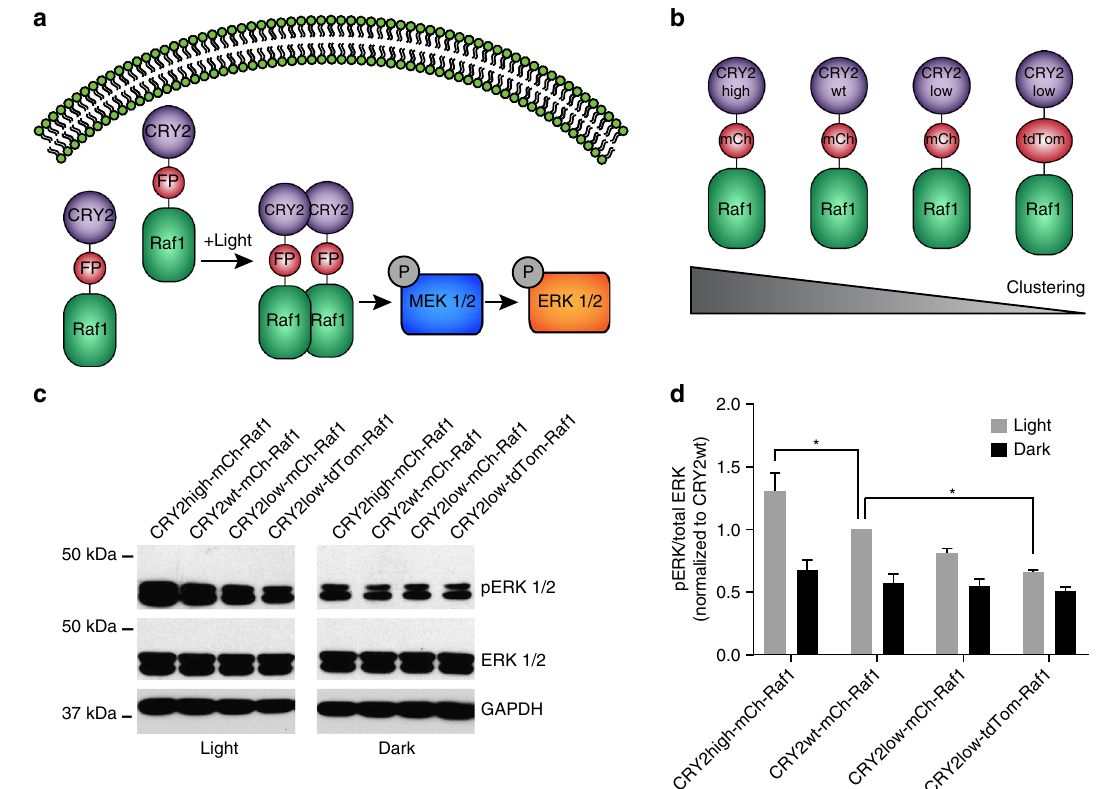
Fig. 5 Optical control of Raf activation using CRY2 constructs with differential clustering capacities. a Illustrative scheme for light-induced activation of MAPK signaling pathway. b Light-activatable Raf1 with different CRY2 oligomerization propensities. c Cells expressing CRY2high-mCh-Raf1 yielded the highest level of pERK after light stimulation, while cells expression CRY2low-tdTom-Raf1 produced the lowest level of pERK after light illumination. Western blot analysis of phosphorylated ERK (pERK, Thr202 and Tyr204) was conduceted after blue light illumination at 0.2 mW cm − 2 for 5 min. d The pERK value decreased from CRY2high-mCh-Raf1, CRY2wt-mCh-Raf1, CRY2low-mCh-Raf1 to CRY2low-tdTom-Raf1 after light stimulation. The pERK value in each transfection was averaged from two technical replicates from two independent experiments. The values were normalized against pERK from cells expressing CRY2wt-mCh-Raf1. Results are presented as means ± s.e.m. and analyzed using one-way ANOVA with Dunnett ’ s post hoc test. (* P <